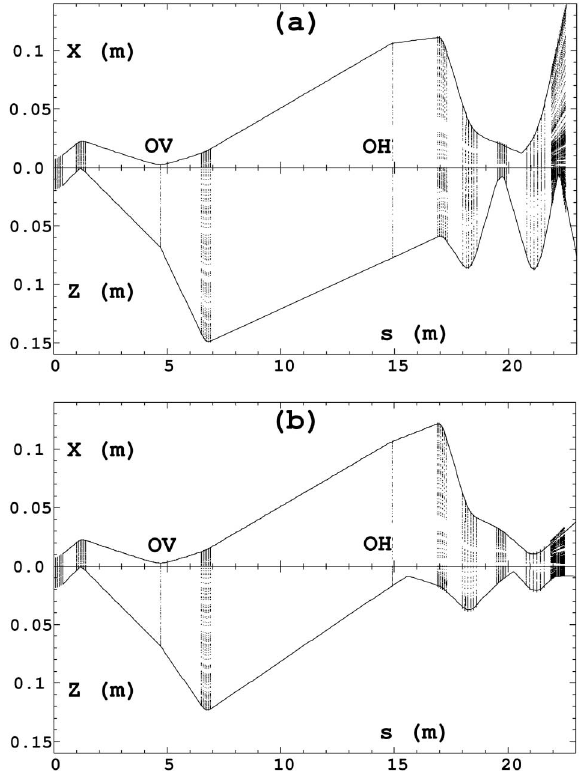
FIG. 3. Nonlinear third order X 3 , Z 3 (cid:1) s (cid:2) [graph (a)] and fifth order X 5 , Z 5 (cid:1) s (cid:2) [graph (b)] beam envelopes [solid lines; after Eq. (5)], and comparison with particle tracking (dotted